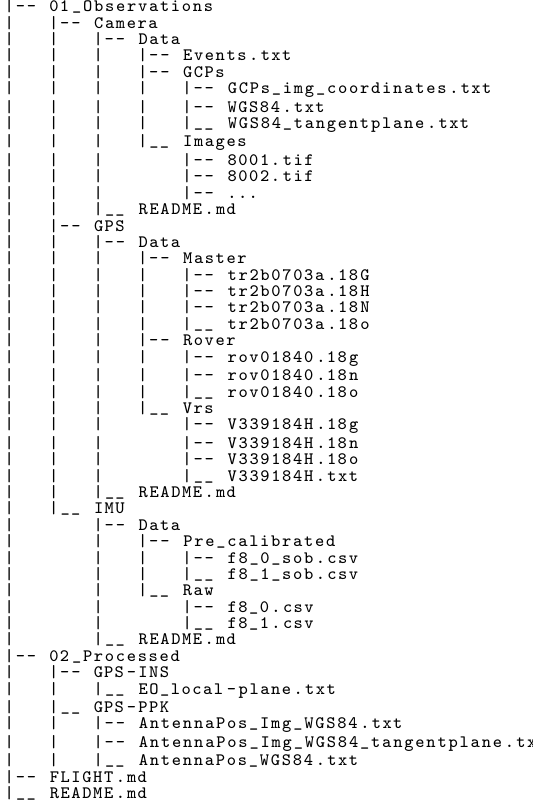
Figure 9. File–folder organization of a data-set ( ign8